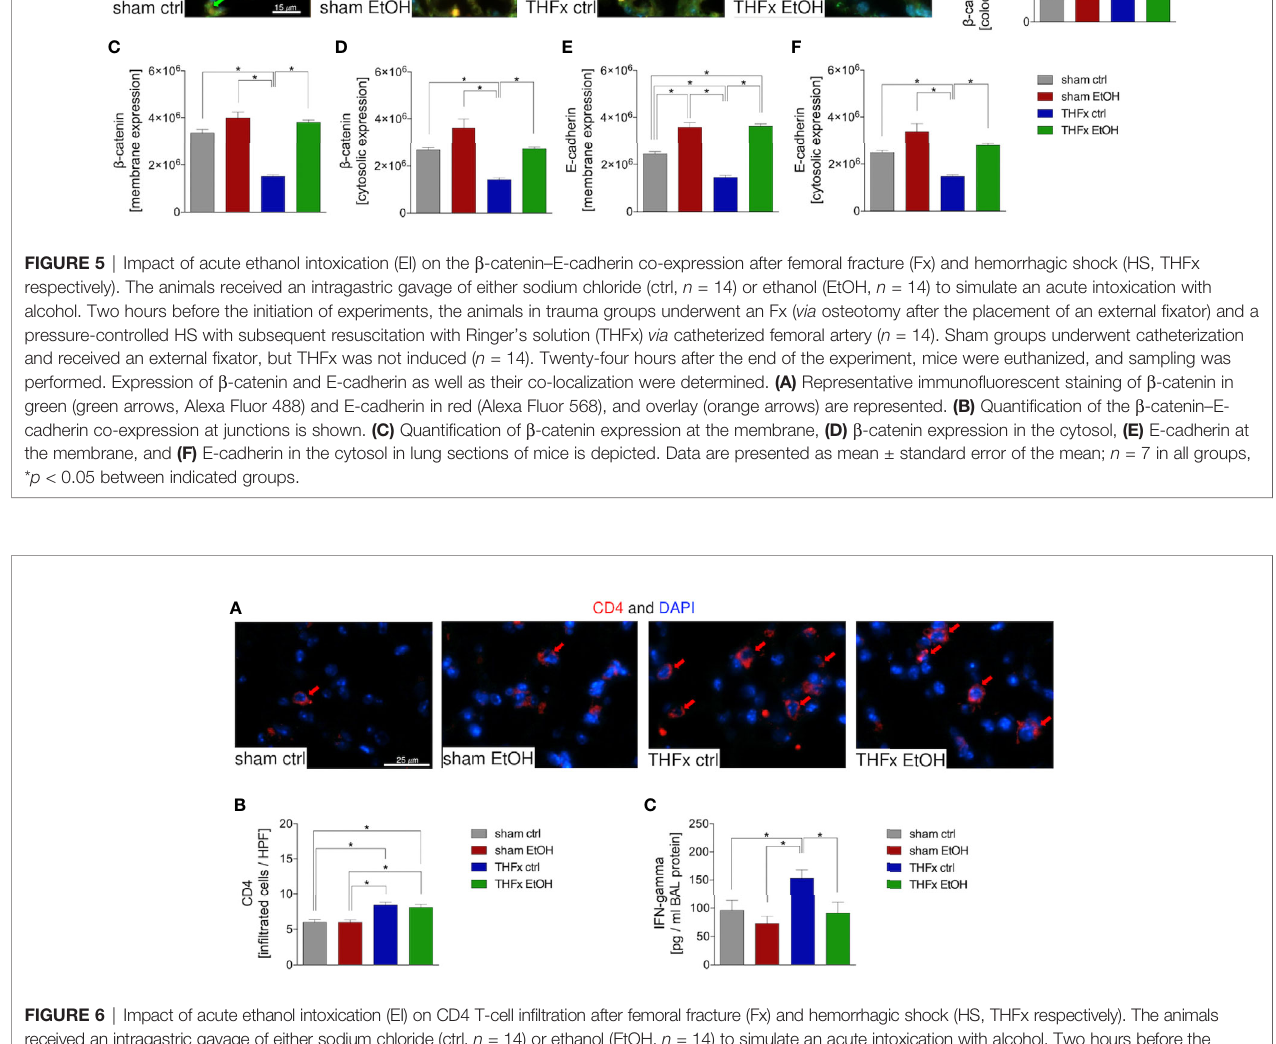
FIGURE 6 | Impact of acute ethanol intoxication (EI) on CD4 T-cell in fi ltration after femoral fracture (Fx) and hemorrhagic shock (HS, THFx respectively). The animals received an intragastric gavage of either sodium chloride (ctrl, n = 14) or ethanol (EtOH, n = 14) to simulate an acute intoxication with alcohol. Two hours before the initiation of experiments, the animals in trauma groups underwent an Fx ( via osteotomy after the placement of an external fi xator) and a pressure-controlled HS with subsequent resuscitation with Ringer ’ s solution (THFx) via catheterized femoral artery ( n = 14). Sham groups underwent catheterization and received an external fi xator, but THFx was not induced ( n = 14). Twenty-four hours after the end of the experiment, mice were euthanized, and sampling was performed. (A) Immuno fl uorescence staining of CD4 in red (red arrows, Alexa Fluor 647) in lung sections of mice was performed, and (B) quanti fi cation of the positively stained cells per HPF is depicted. (C) Quanti fi cation of interferon (IFN)-gamma protein concentration in bronchoalveolar lavage (BAL) fl uid is represented. Data are presented as mean ± standard error of the mean; n = 7 in all groups, * p < 0.05 between indicated